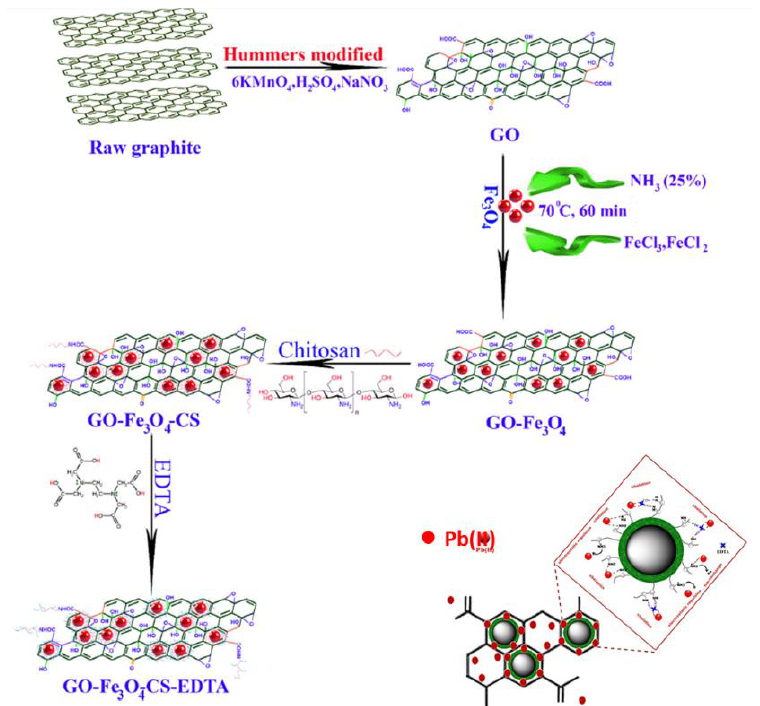
Figure 5. Schematic of the synthesis procedure of GO-Fe 3 O 4 -chitosan-EDTA nanocomposite and the proposed mechanism for its interaction with Pb(II) [41].